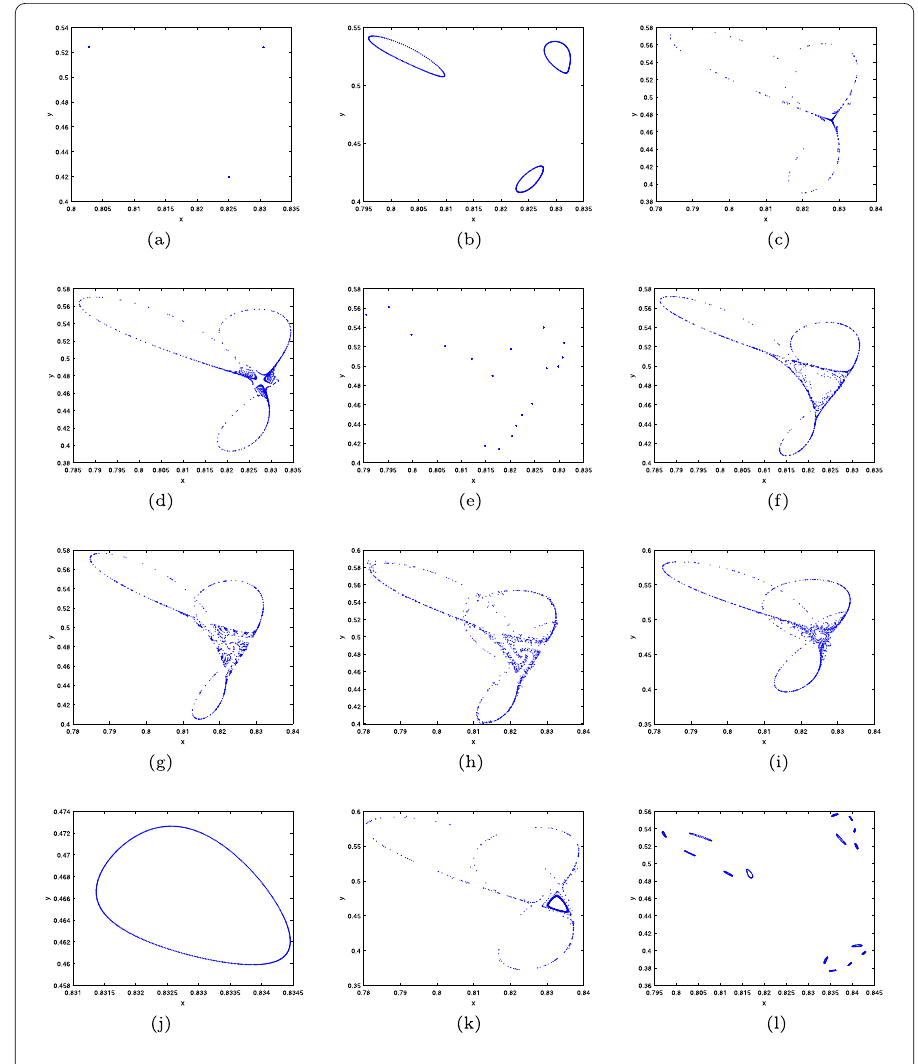
Figure 5 Phase portraits for different values of ( ρ 1 , μ ). ( a ) ρ 1 = 1.2, μ = 3.3118; ( b ) ρ 1 = 1.2, μ = 3.3148; ( c ) ρ